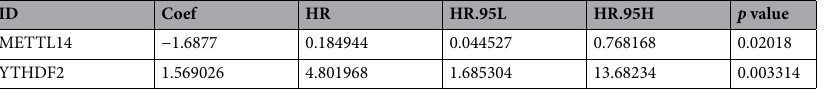
Table 3. Results of the multivariate COX regression analysis. Table shows the detailed results of the multivariate COX regression